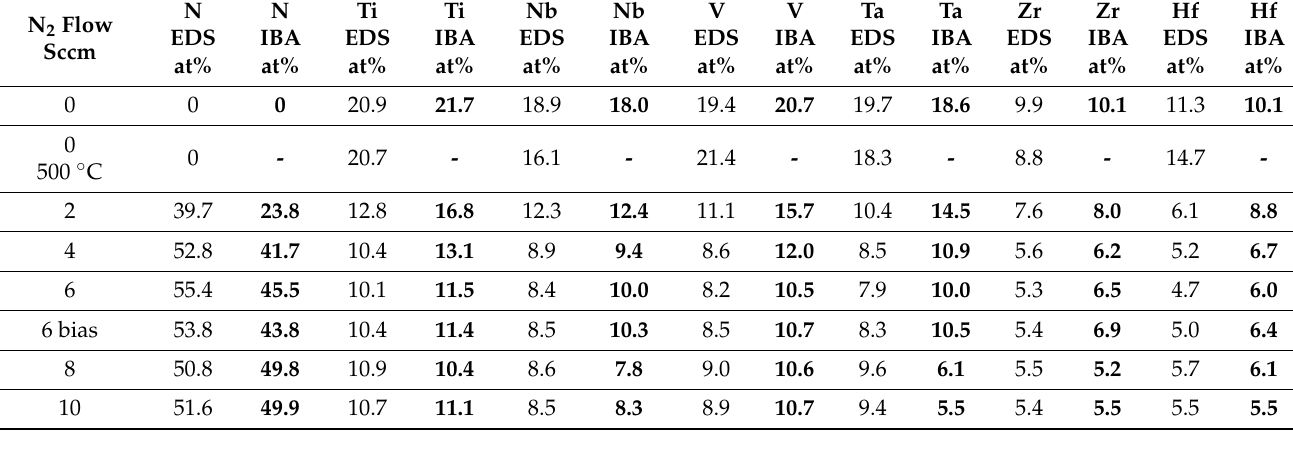
Table 5. The comparison of the concentrations of transition metals and nitrogen in the studied HiTUS TiNbVTaZrHf-xN coatings determined by EDS/SEM and by IBA methods.